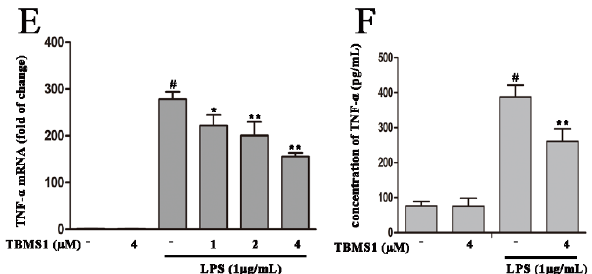
Figure 5. Effects of TBMS1 on the mRNA and protein levels of pro-inflammatory cytokines in LPS-exposed BV-2 cells. The BV-2 cells were pretreated with TBMS1 for 1 h, and then incubated with LPS (1 µ g/mL)